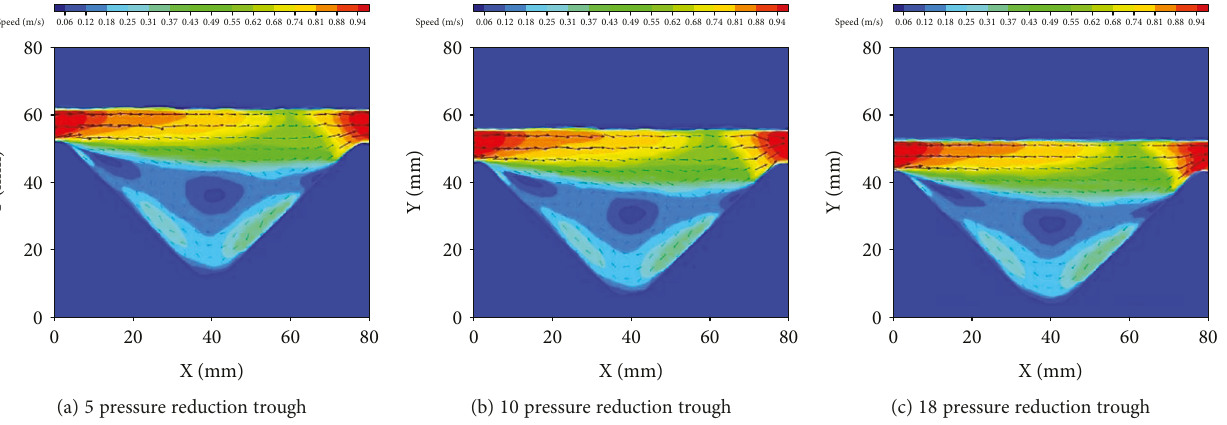
Figure 7: Velocity nephograms of the polymer solution that fl owed through the partially pressured injection tool with di ff erent number of